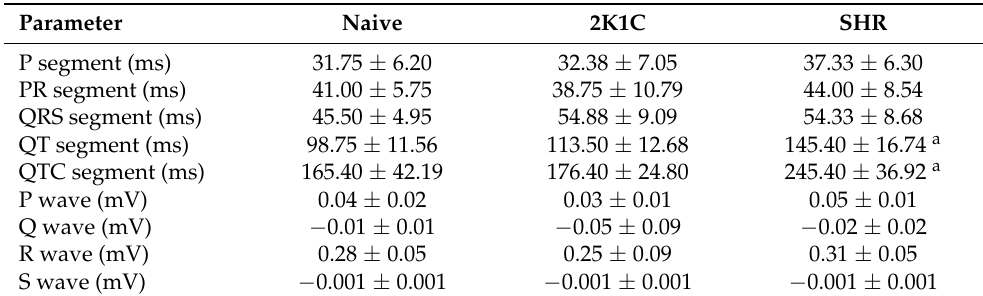
Table 2. Electrocardiographic parameters of the different experimental groups at the end of 6 weeks of treatment with the high-fat diet.